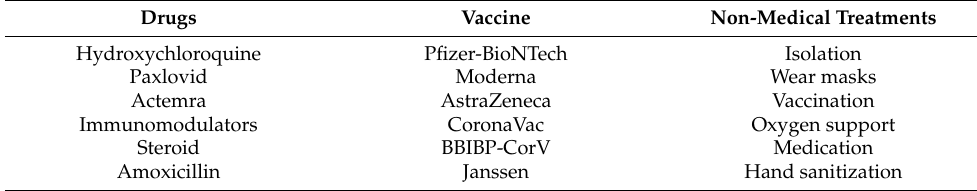
Table 7. Most prevalent named entities under entity types (drugs, vaccine, treatments).